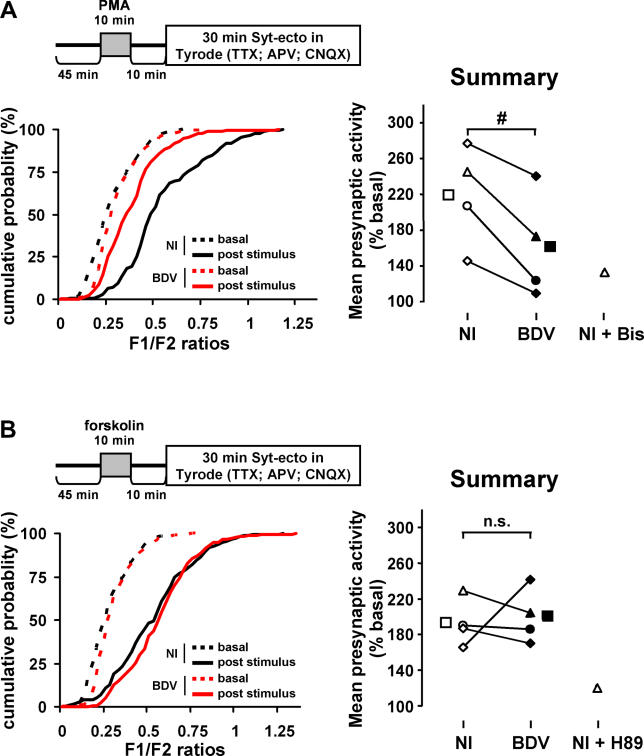
PMA, but Not Forskolin-Induced Potentiation of Vesicular Recycling Is Impaired in BDV-Infected NeuronsCumulative probability distributions of fluorescence ratios (F1/F2) for individual synapses for the analysis of SV recycling in spontaneous conditions and after (A) PMA treatment or (B) forskolin treatment. The overview of the experimental stimulation protocol is depicted above each graph. The level of SV recycling is significantly lower in BDV-infected neurons compared to NI neurons after stimulation with PMA (p < 0.001 using KS test). Pairwise comparisons of mean presynaptic activities in independent experiments involved at least 180 synapses (small symbols). Bigger squares correspond to mean values of all independent experiments. Similar results were found in four independent experiments. Also shown are results for NI neurons treated with the PKC inhibitor Bis or the PKA inhibitor H89. Hash mark (#) indicates p < 0.05. n.s., not significant, by paired t test.